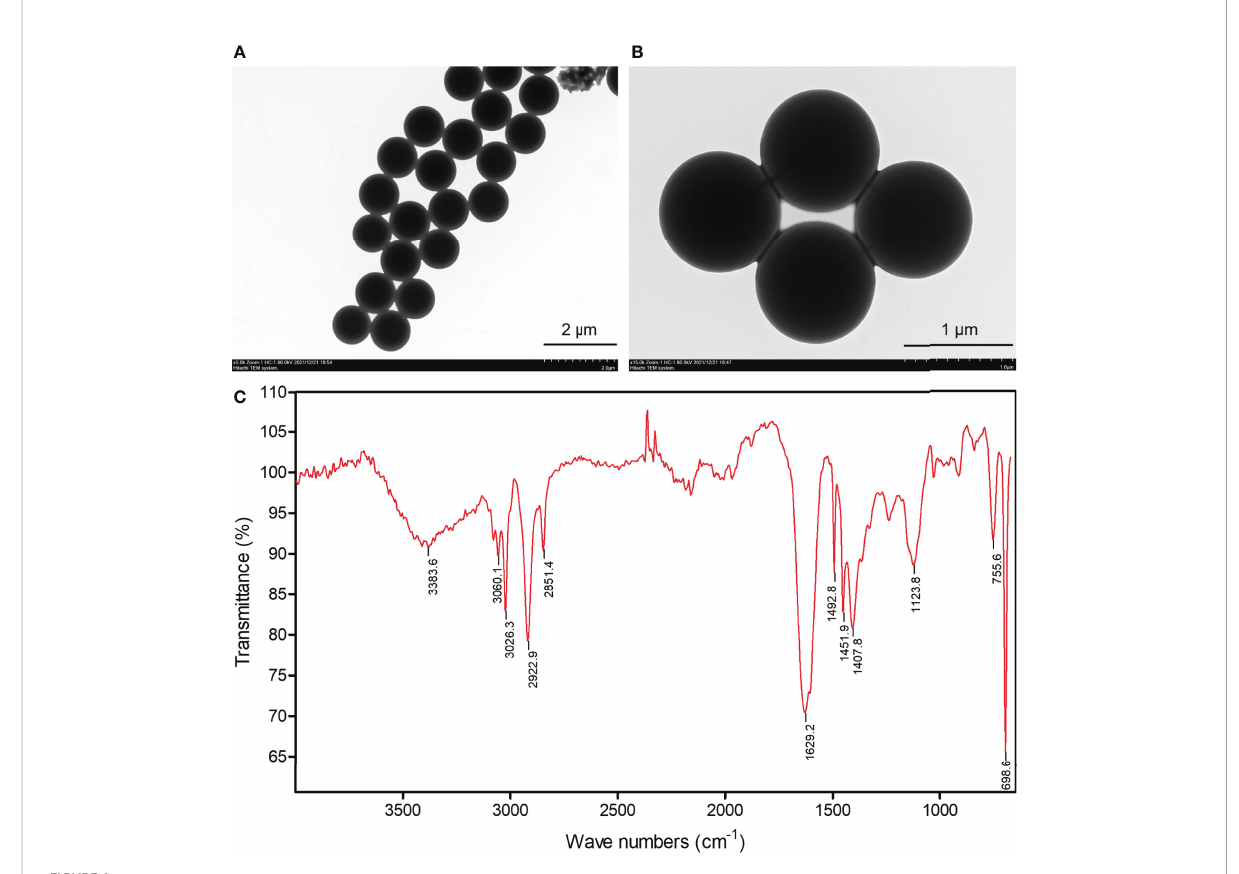
FIGURE 1 TEM images (A, B) and FTIR spectrum (C) of 1- m m PS